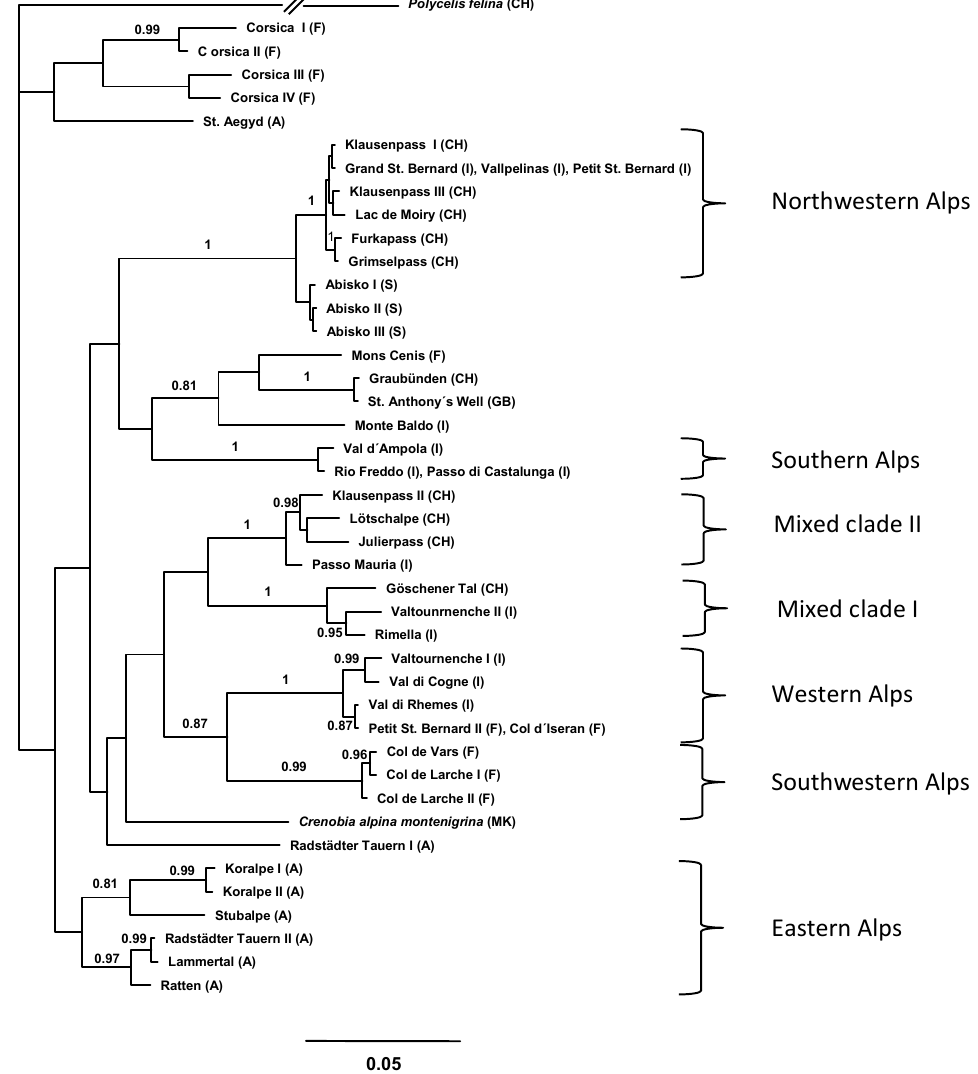
Figure 2. Bayesian phylogeny of Crenobia alpina haplotypes based on mitochondrial COI and nuclear 18S rRNA gene fragments (overall 981bp). Tip labels refer to locations sampled and analyzed (Supplement Tables S1 and S2). Posterior probabilities ( > 0.8) are shown on the nodes. Haplotypes were named according to their geographical location, and the names are followed by the country code in parentheses (Supplement Table S1). Genetically and geographically distinct groups are indicated by braces referring to the geographic position within the Alps on the right side of the figure. For details about sampling localities, see